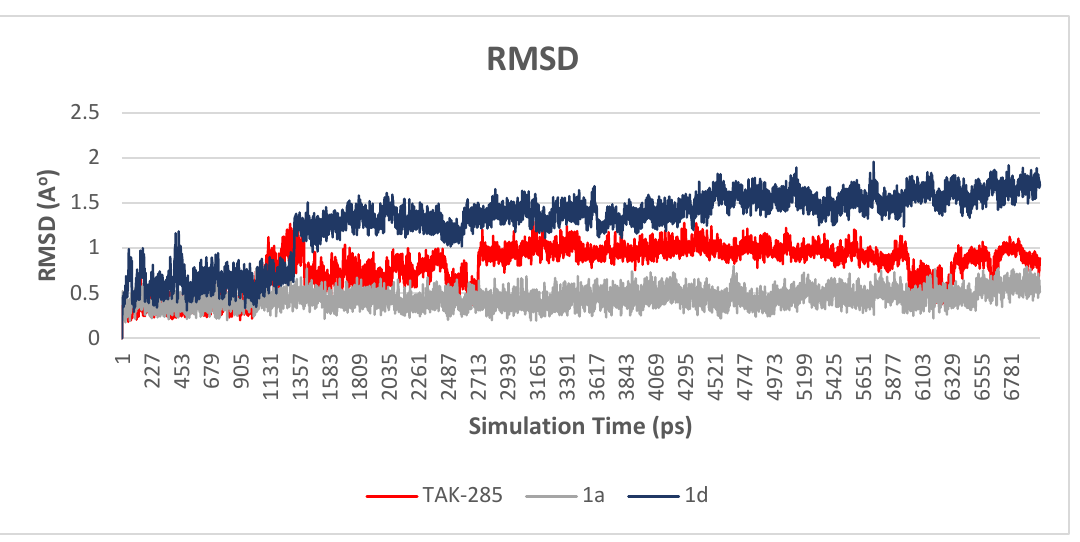
Figure 5. Plot of RMSD vs. time graph for TAK-285 (red), 1a (gray) and 1d (blue). Compound 1a shown to be fluctuating around 0.5 Å, while compounds 1d and TAK-285 were fluctuating around 1.4 and 1.0 Å.